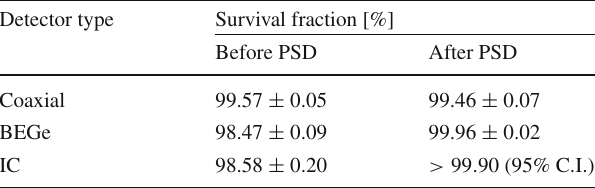
Table 1 Survival fractions of 2 νββ decay events for the δ E cut without and in combination with other PSD methods ( A / E or ANN+risetime). The uncertainties are statistical